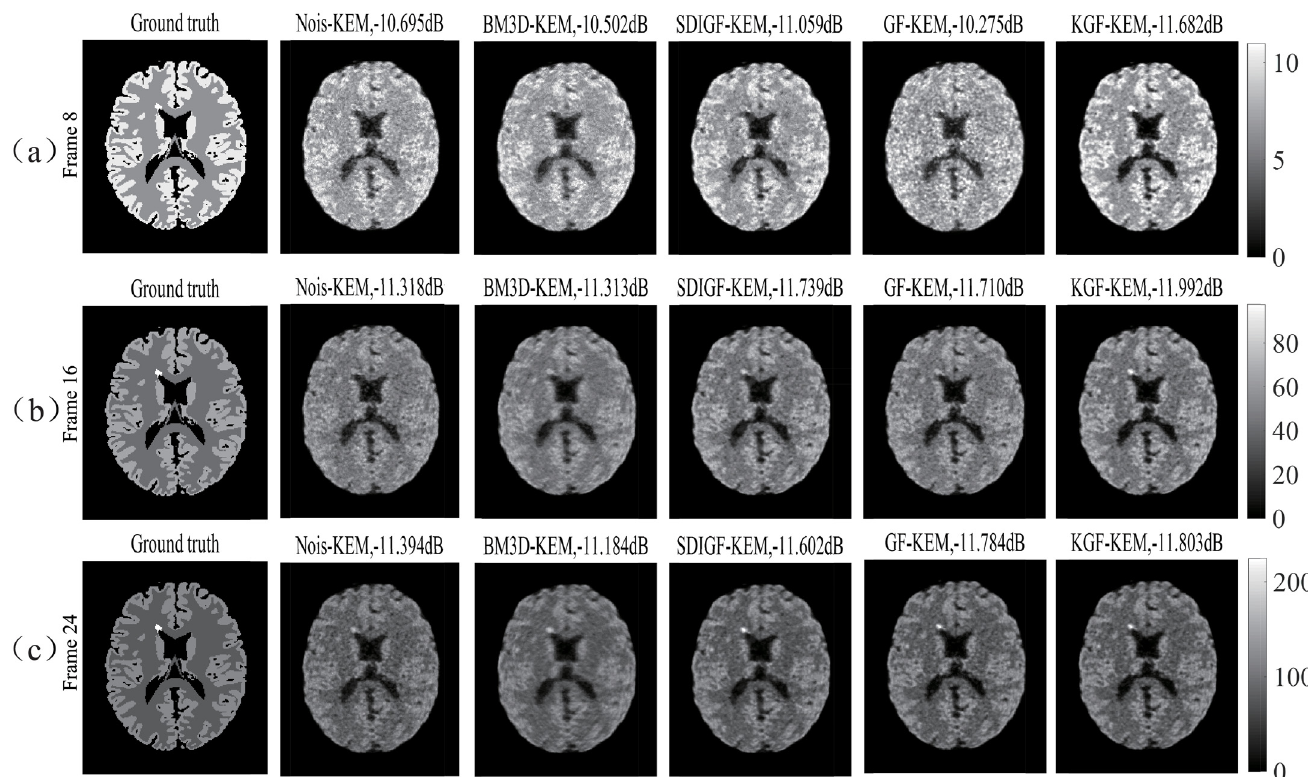
Fig 7. KEM reconstructed images from corresponding sinogram datasets shown in Fig 2. (a) Frame 8, (b) Frame 16, and (c) Frame 24. The dB values are MSEs of reconstructed images.